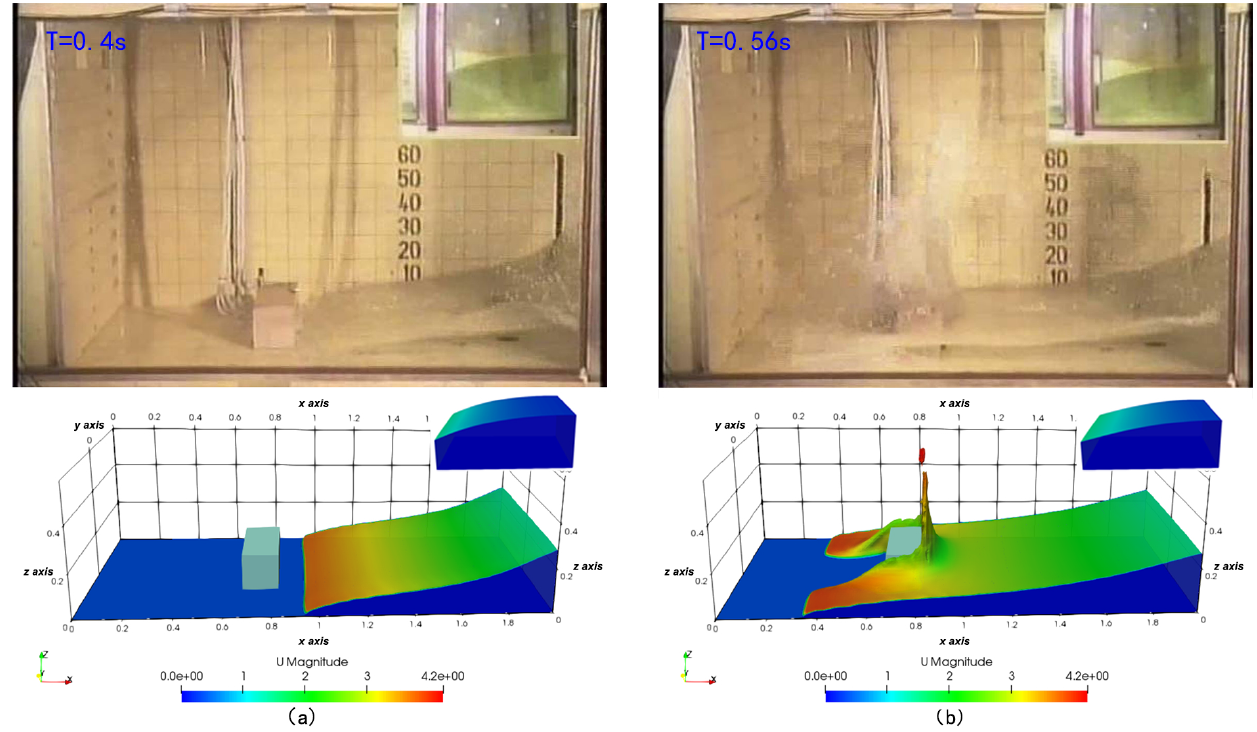
Figure 4. Screenshots of the simulation compared with the experiment (Kleefsman et al., 2005) at t = 0 . 4s (a) and t = 0 . 56s (b) . The color map of the simulation results is mapped by velocity characteristics.